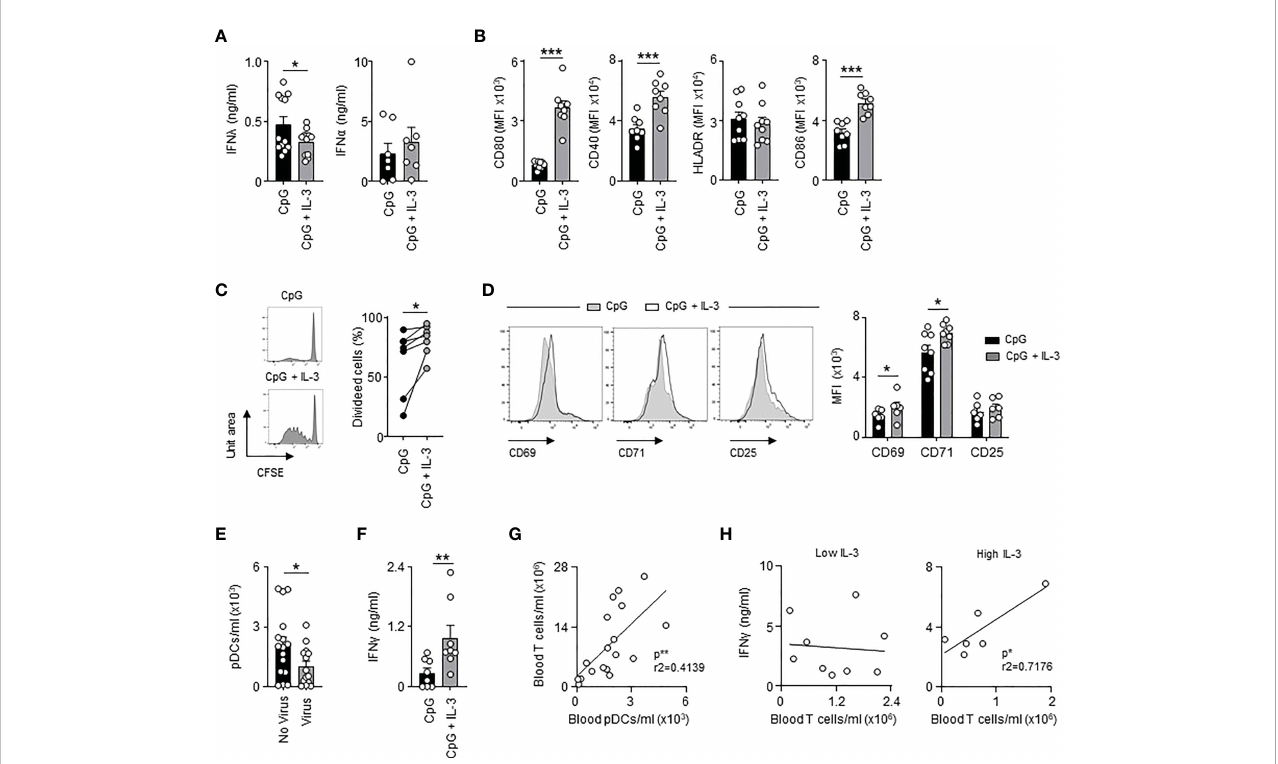
FIGURE 4 Interleukin-3 enhances pDC-mediated adaptive antiviral immunity. (A) Levels of IFN l and IFN a in culture supernatant of circulating pDCs from healthy donor 24h after CpG stimulation in the presence or the absence of IL-3 (n=7-12). (B) Cumulative mean fl uorescence intensity (MFI) of CD80, CD40, HLADR and CD86 expressed at the surface of circulating pDCs 24h after CpG stimulation in the presence or the absence of IL-3 (n=8-9). (C – E) Allogenic T cells were cocultured during 6 days with CpG-activated pDCs pre-treated or not with IL-3. (C) Representative histogram and percentage of proliferating allogenic T cells (n=7). (D) Representative histogram and cumulative mean fl uorescence intensity (MFI) of CD69, CD71 and CD25 expressed at the surface of allogenic T cells (n=6-8). (E) Concentration of pDCs in blood of septic patients that developed viral pneumonia or not (n=32). (F) Levels of IFN g in culture supernatant (n=8). (G) Correlation between the concentration of T cells and pDCs in blood of septic patients (n=18). Data were analysed by Pearson correlation test. (H) Correlation between plasma IFN g levels and the concentration of T cells in blood of septic patients with low (n=9) or high (n=6) plasma IL-3 levels. Patients with low IL-3 are patients with a level of IL-3 under the mean (61.7 pg/ml) of all the patients. Patients with high IL-3 are patients with a level of IL-3 above the mean (61.7 pg/ml) of all the patients. Data were analysed by Pearson correlation test. Data are mean ± s.e.m., *P < 0.05, **P < 0.01, ***P < 0.001, paired 2-tailed Student ’ s t test or unpaired 2-tailed Student ’ s t test using Welch ’ s correction for unequal variances were